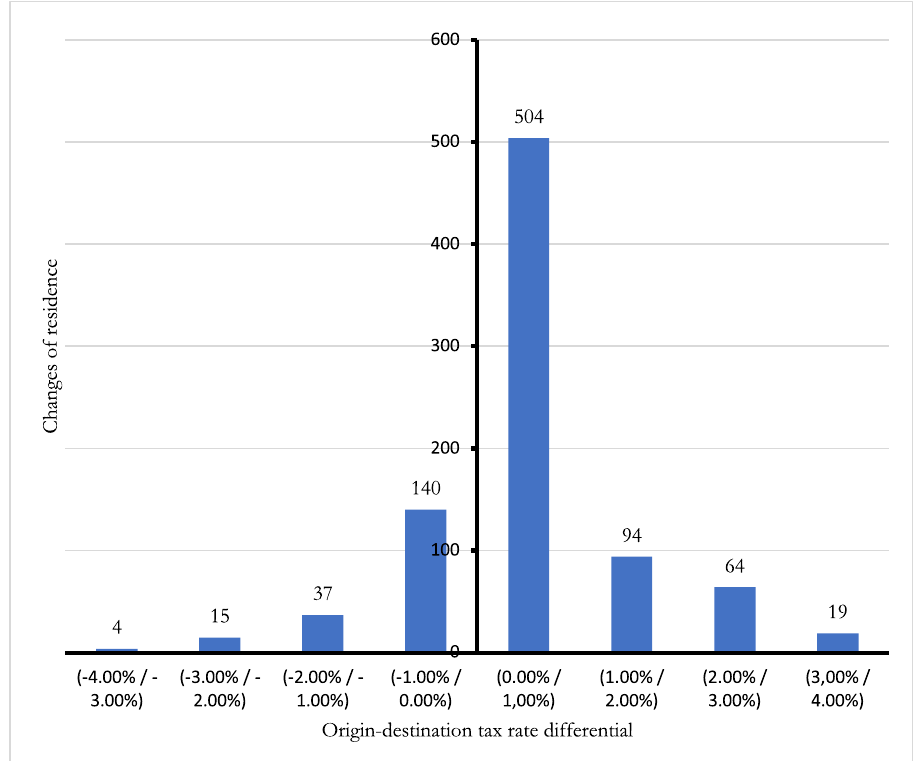
Figure 1: Distribution of changes of residence according to the di ff erence in IRPF average rates between the regions of origin ( in 2006 ) and destination ( in 2012 )